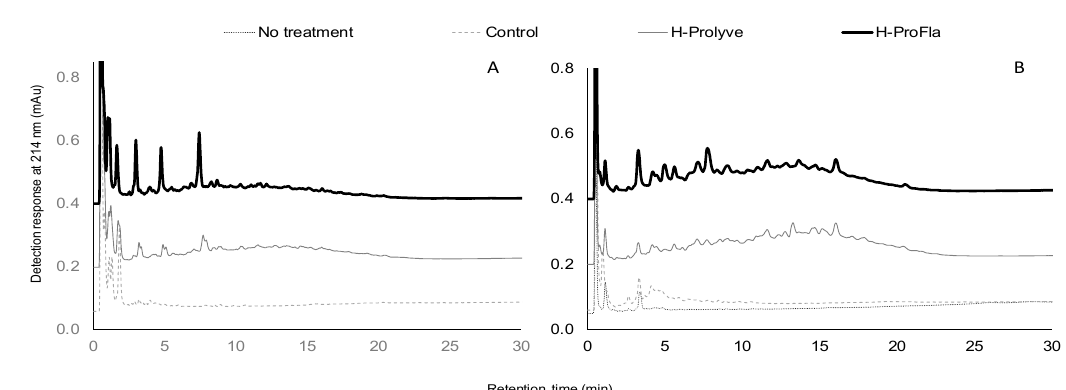
Figure 3. Analytical reverse-phase ultra-performance liquid chromatography profiles of blades ( A ) and protein isolate ( B ) of Porphyra dioica following 2 h hydrolysis at 50 ◦ C with Prolyve ® 1000 (H-Prolyve) and a 4 h hydrolysis with Prolyve ® 1000 plus Flavourzyme ® (H-ProFla). No treatment: no enzyme addition without incubation at 50 ◦ C for 4 h; Control: samples incubated at 50 ◦ C for 4 h without